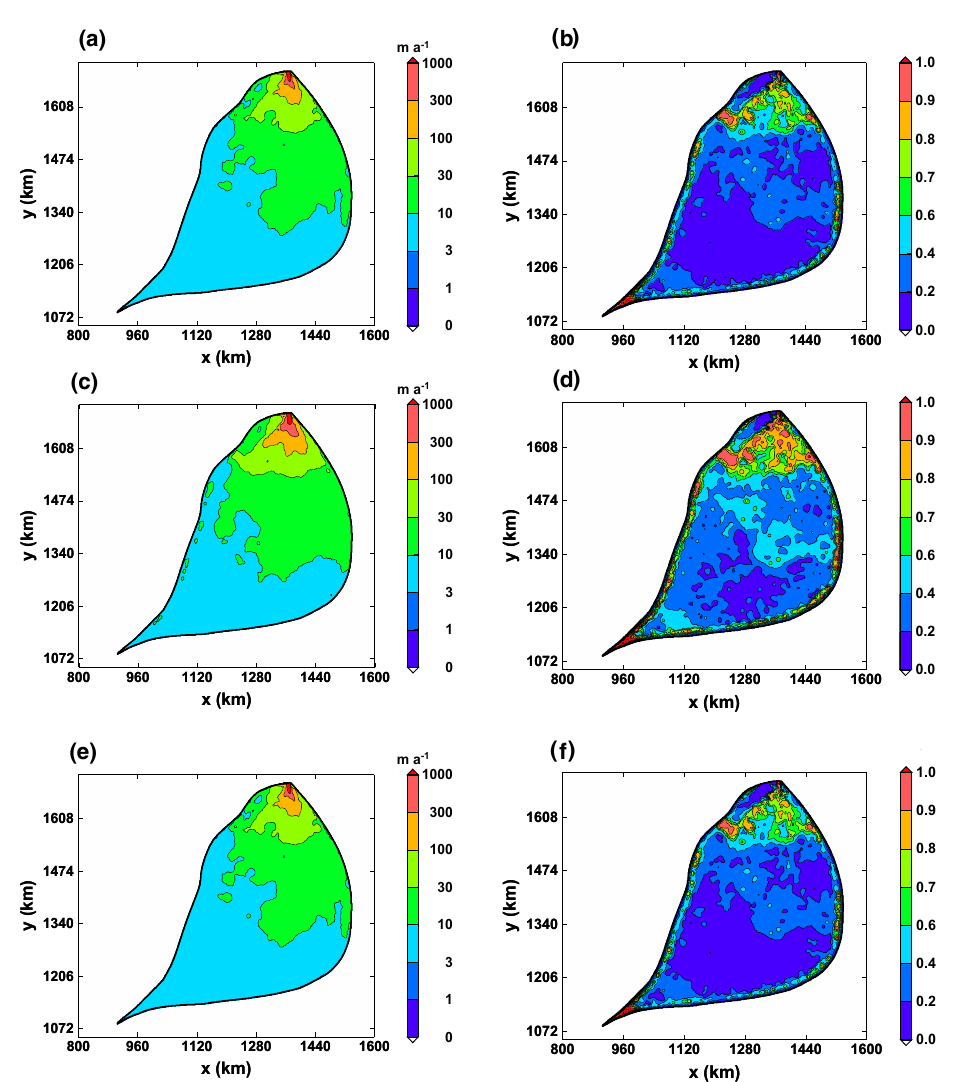
Figure 6. Surface velocities (a, c, e) and slip ratios (b, d, f) computed with the FS dynamics for experiment CTL (constant-climate control run; a, b ), S1 (basal sliding experiment; c, d ) and C2 (surface climate experiment; e, f ) at t = 100 years (year